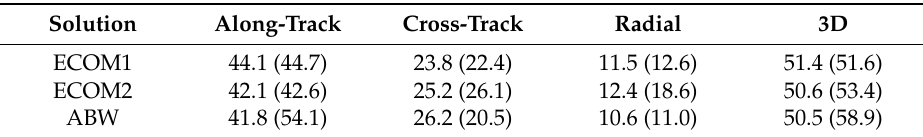
Figure 3. Time series of orbit boundary discontinuities (OBDs) for ( a ) ECOM1, ( b ) ECOM2 and ( c ) ABW solutions of BeiDou-3 I2-S. The red, green and blue curves represent OBDs in along-track, cross-track and radial direction, respectively. Table 2. Mean value of OBDs in Along-track, Cross-track, radial and 3D for BeiDou-3 I2-S ECOM1, ECOM2 and ABW solutions. Values in brackets was for eclipse season (unit: cm).